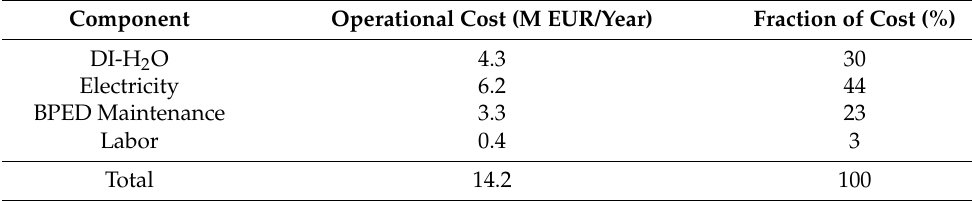
Table 4. OPEX estimations for operation of the BPED